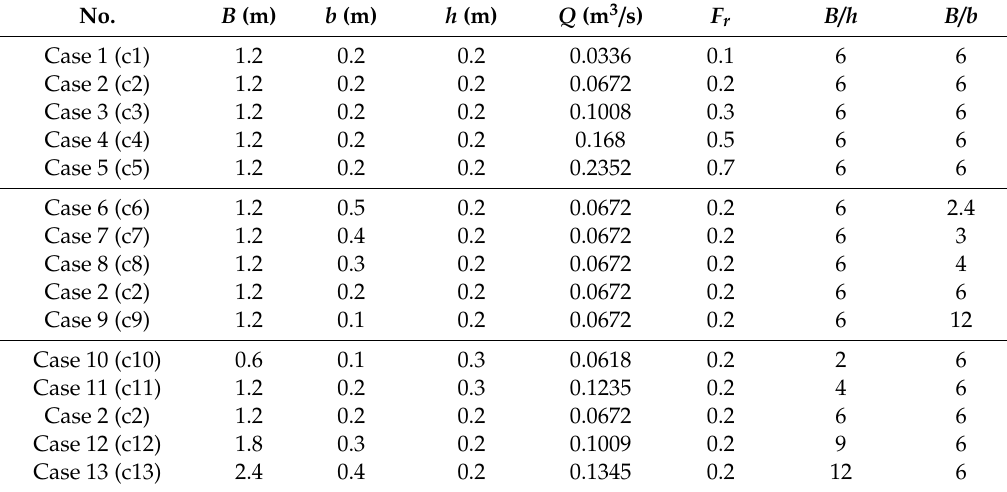
Table 2. Simulation conditions of cases.